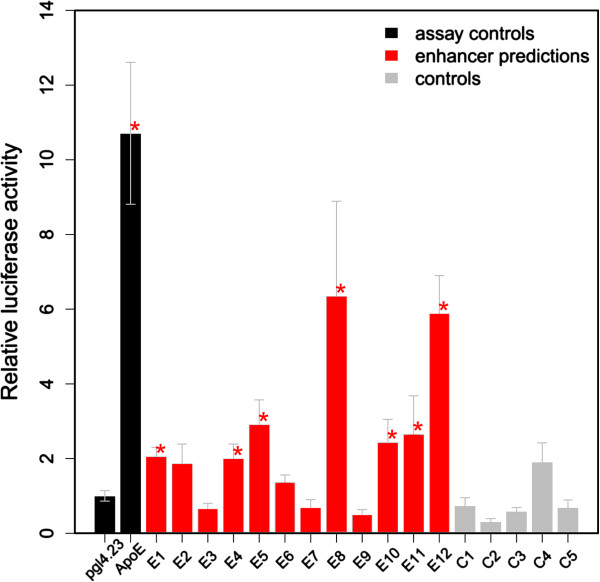
Experimental validation of liver enhancer predictions using the hydrodynamic tail vein enhancer assay. On each injection day, we also injected an empty pGL4.23[luc2] vector and a known liver enhancer of the ApoE gene as negative and positive controls, respectively. At least three mice were injected per construct. Statistical significance was tested using Student’s t-test followed by multiple testing adjustment with Benjamini-Hochberg’s method. The asterisks indicate statistical significance to control at adjusted P-value ≤0.05.